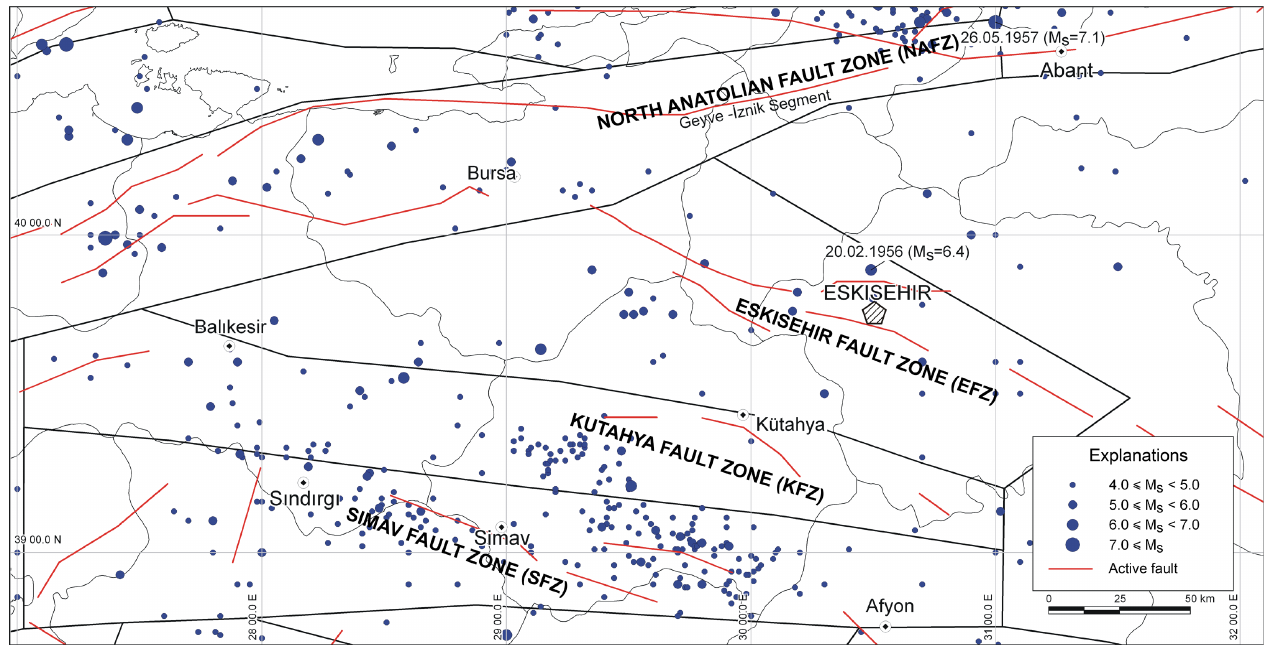
Fig. 4. Seismic sources and earthquakes that occurred during the last